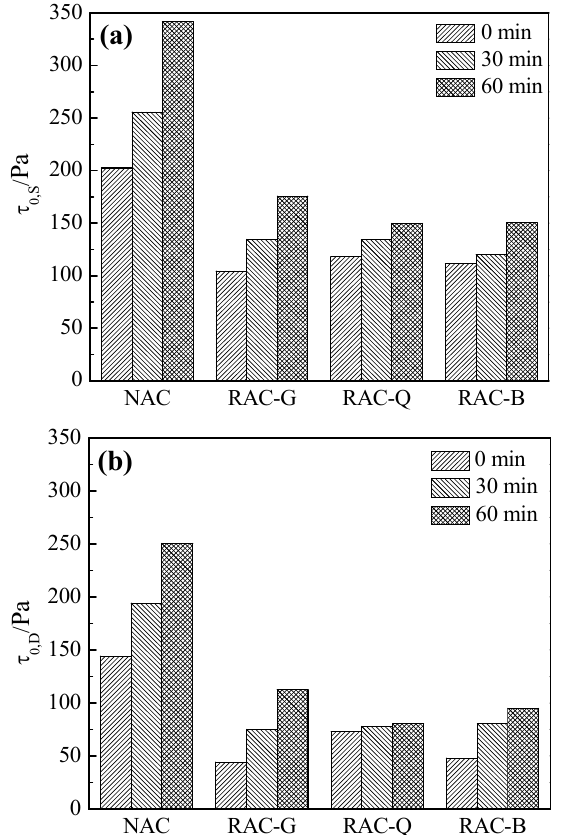
Figure 3. Effects of different coarse aggregates on the rheological properties of concrete ( a ) static yield stress; ( b ) dynamic yield stress.